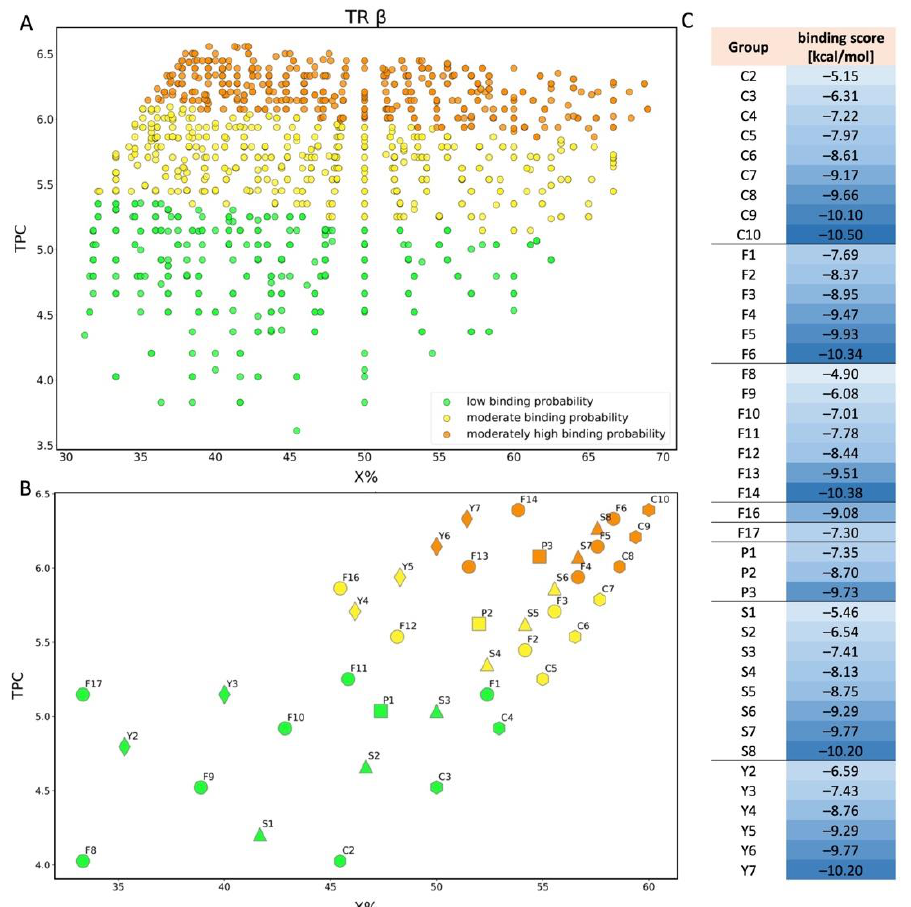
Figure 10. Scatter plot of binding scores obtained for TR β in X% and TPC space ( A ); scatter plot for TR β showing the division of PFAS into 5 different structural groups in space of TPC and X%. C-carboxylic acids (COOH-(CF2)n-CF3), S-sulfonic acids (SO3H-(CF2)n-CF3), P-phosphonic acids (PO3H2-(CF2)n-CF3, F–Fluorotelomer alcohol (F1–F7 (OH-(CH2)-(CF2)n-CF3), F8-F14 (OH-(CH2)2- (CF2)n-CF3), F16 (OH-(CH2)3-(CF2)n-CF3), F17 (OH-(CH2)4-(CF2)n-CF3)), Y-dicarboxylic acids (COOH-(CF2)n-COOH). Colors: green-low binding probability, yellow-moderate binding probabil- ity, orange-moderately high binding probability ( B ); table showing binding score values for each compound shown in chart B ( C